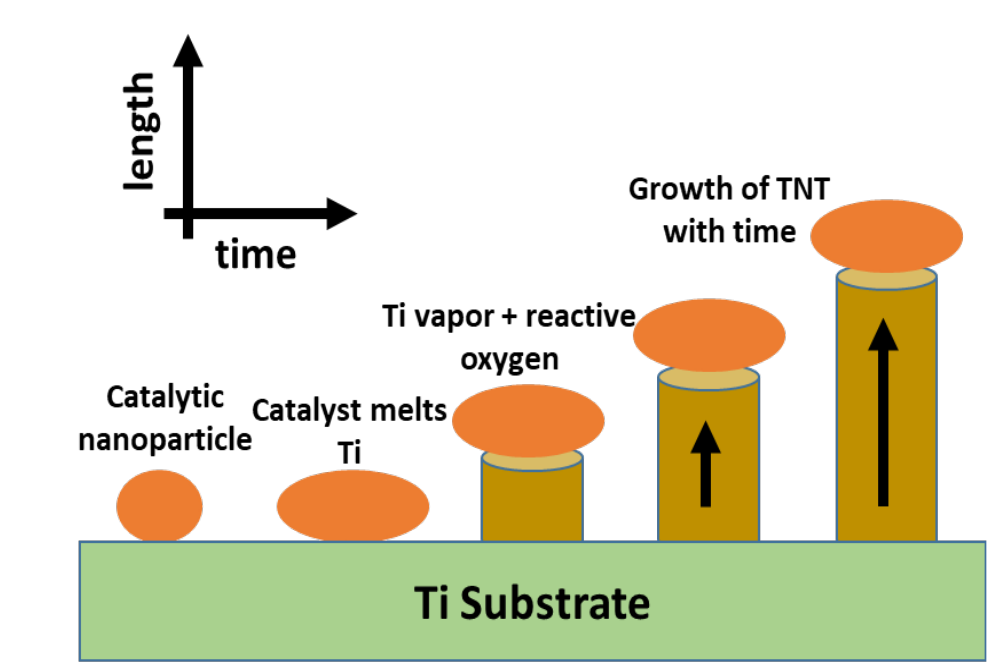
Figure 3. Synthesis of TNTs via catalyst-assisted VLS .